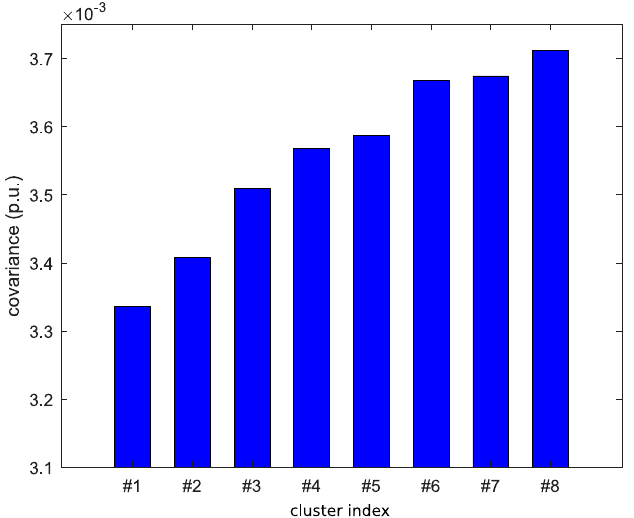
Figure 11. Covariance of the aggregate cluster consumption 𝑈 (cid:3046),(cid:3030) (𝑡) and corresponding FR allocation 𝑅 (cid:3046),(cid:3030) (𝑡,𝑈 (cid:3046),(cid:3030) )) expressed in per unit of the steady-state level 𝑈 (cid:3046),(cid:3030),(cid:2868) for different clusters 𝑐 = {1, …,8}